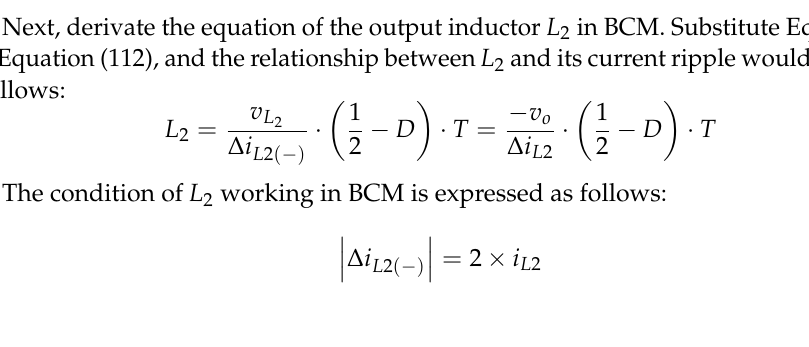
Figure 22. The calculated value of inductance L 1 in the boundary mode.